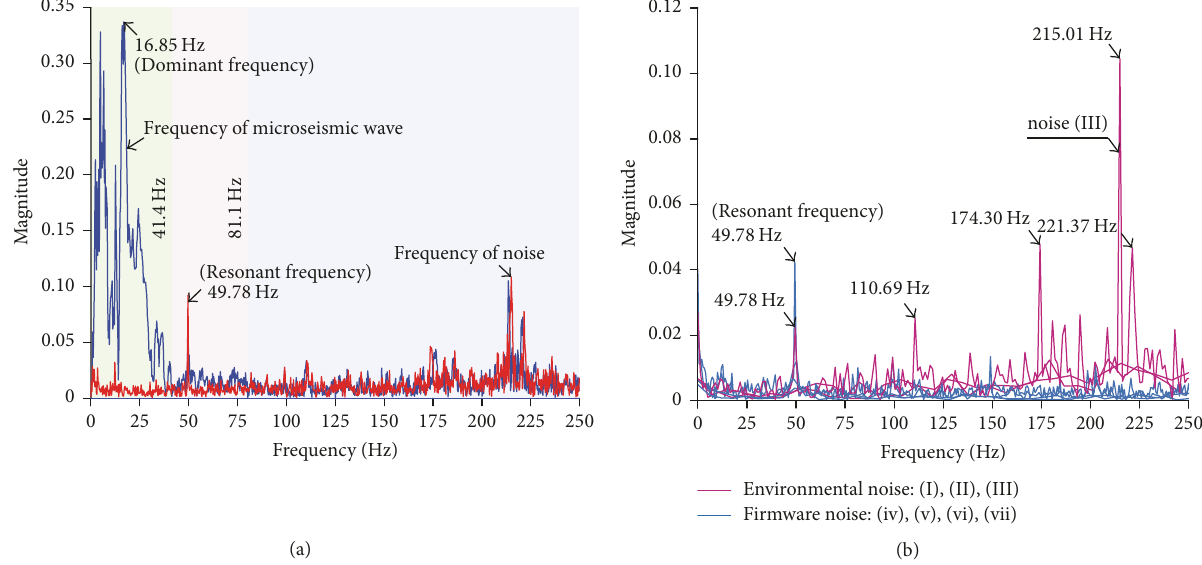
Figure 6: Comparison of the frequency spectra of standalone environmental noise (I, II, III) and firmware noise (iv, v, vi, vii), integrated random noise, and the measured microseismic wave.